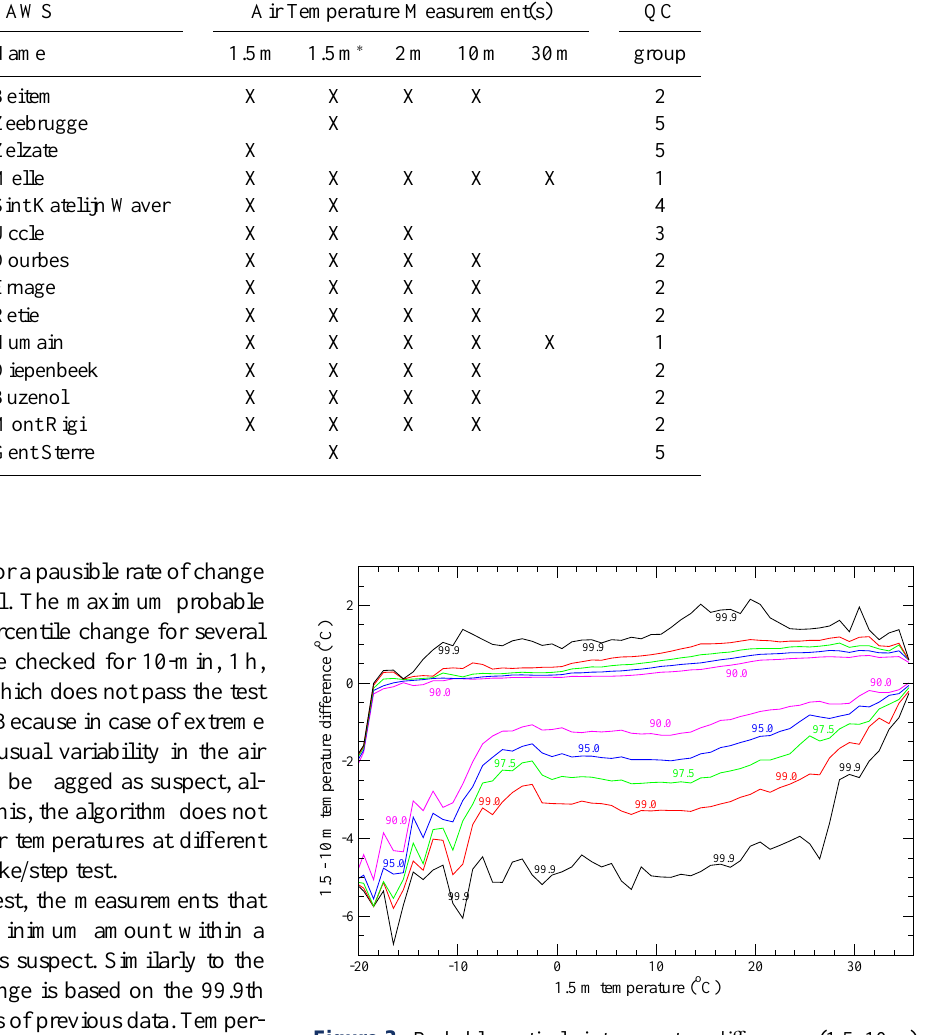
Figure 3. Probable vertical air temperature di ff erences (1.5–10m) as a function of the 1.5-m temperature.